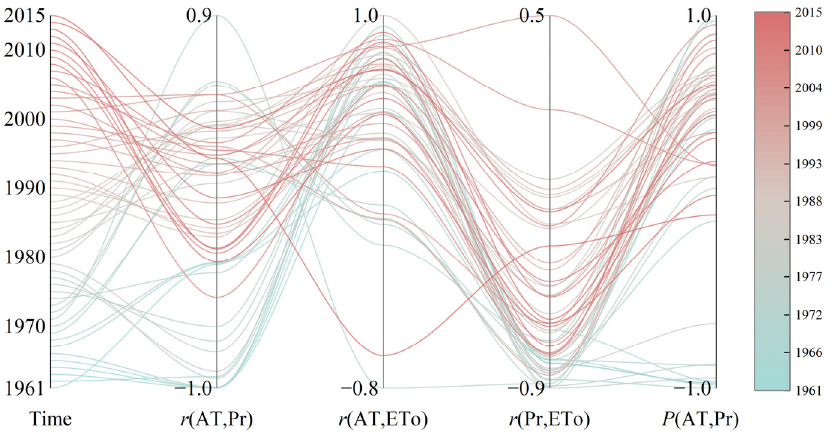
Figure 6. Dynamic correlation between AT and precipitation. Note: According to WTC, the LRCC of this study is 5 years. r(AT,Pr) is the LRCC of AT-precipitation, r(AT,ETo) is the LRCC of AT-ETo, r(Pr,ETo) is the LRCC of precipitation-ETo, P(AT,ETo) is the actual correlation coe ffi cient of AT-precipitation.